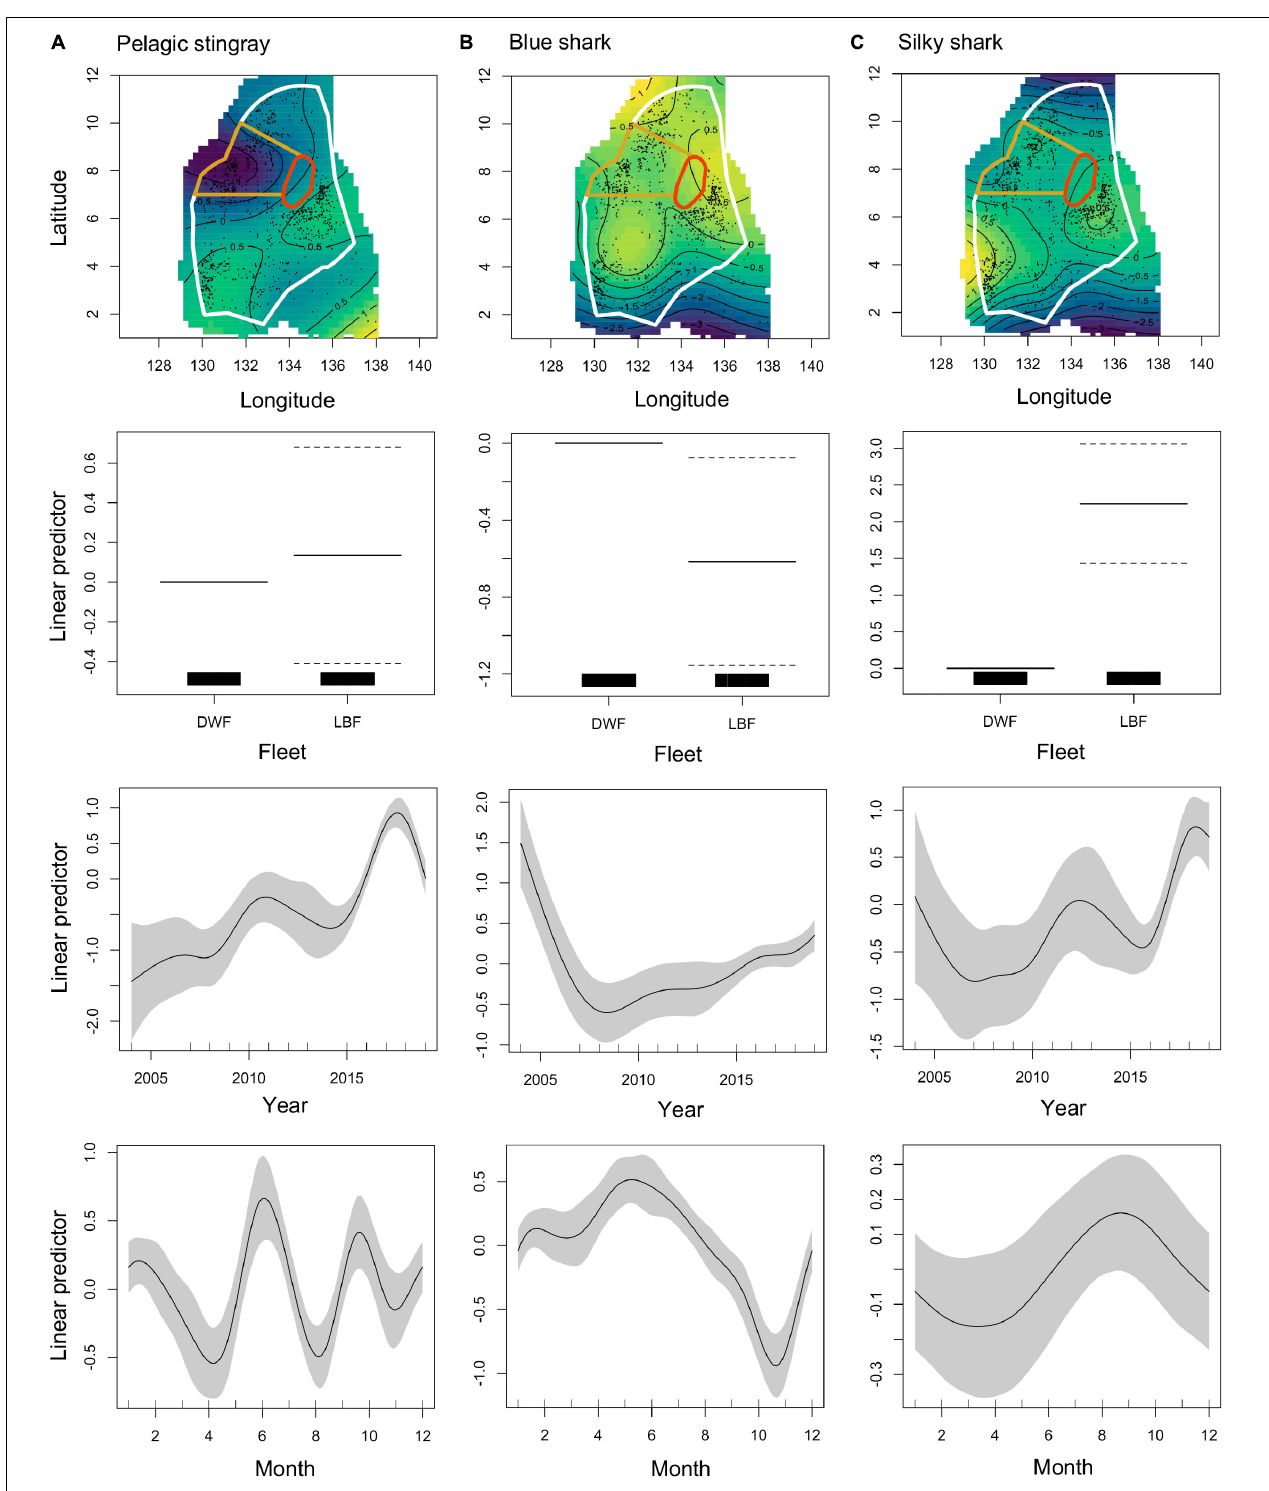
FIGURE 7 | Effect plots of the catch rate models for panel (A) pelagic stingray (Pteroplatytrygon violacea) , (B) blue shark (Prionace glauca) and (C) silky shark (Carcharhinus falciformis) . Darker and lighter colors on the maps (top row) indicate lower and higher catch rates, respectively. Black lines on the maps indicate contours of the spatial surface, and small black dots represent observations. In the second row, solid lines and dashed lines represent the parameter estimate and its standard error, respectively. For the year and month effects (bottom two rows), gray contours are provided for 95% confidence intervals (CI). Note that y -axis scale varies across